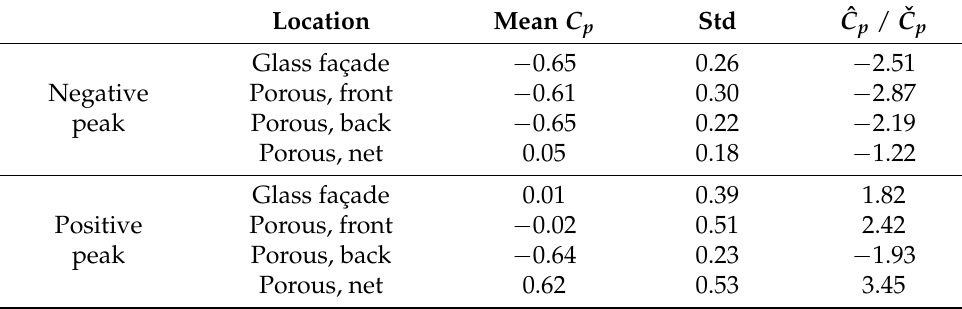
Table 2. Pressure taps statistics, wind direction 0°.